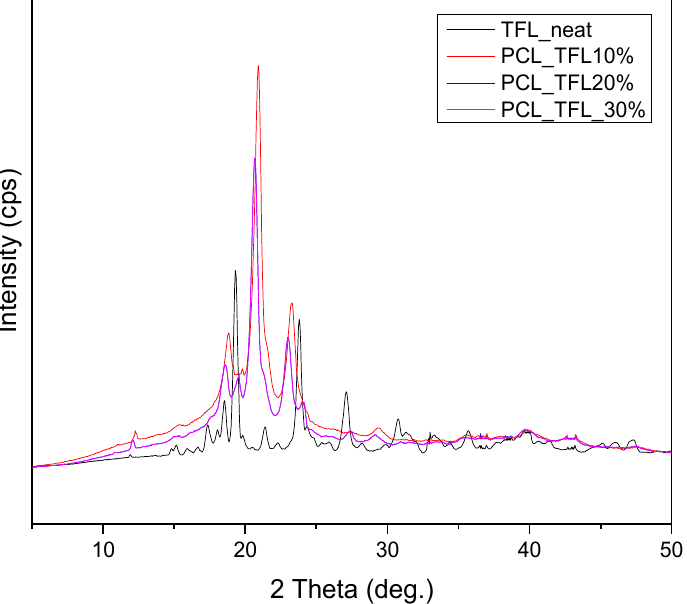
2 Theta (deg.) 2 Theta (deg.) Figure 8. XRD diffractograms of the drug-loaded Figure 8. XRD diffractograms of the drug-loaded samples. Figure 8. XRD diffractograms of the drug-loaded samples.